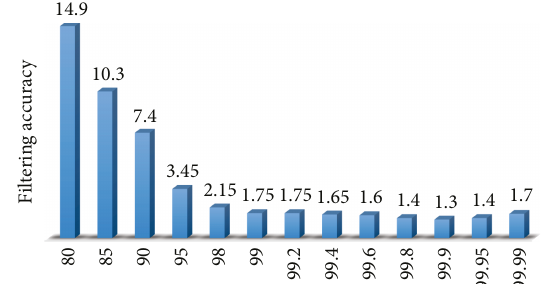
Figure 6: Misclassi fi cation rate after using Bayesian fi lter under di ff erent μ